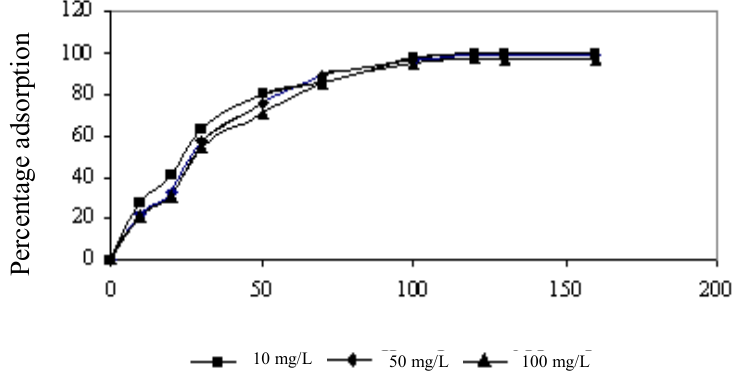
Figure 3. The effect of the contact time on the adsorption of U(VI) by